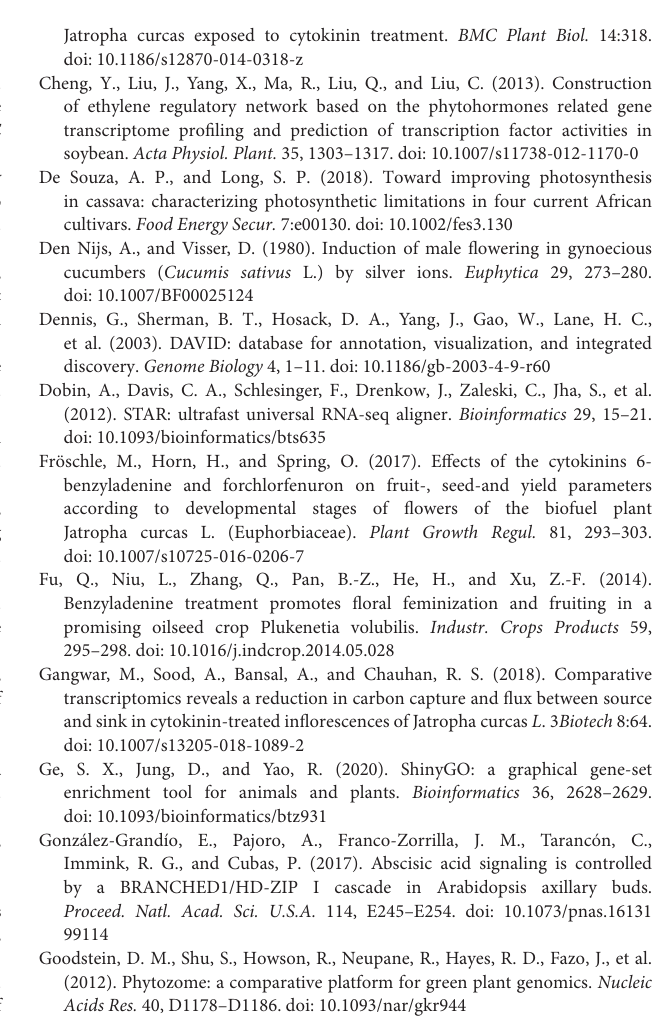
Supplementary Table 4 | Differentially expressed genes (DEGs) with respect to control and PGR treatments. DESeq pgr vs. control. Supplementary Table 5 | Differentially expressed genes (DEGs) with respect to control and pruned treatments. DESeq pruned vs.